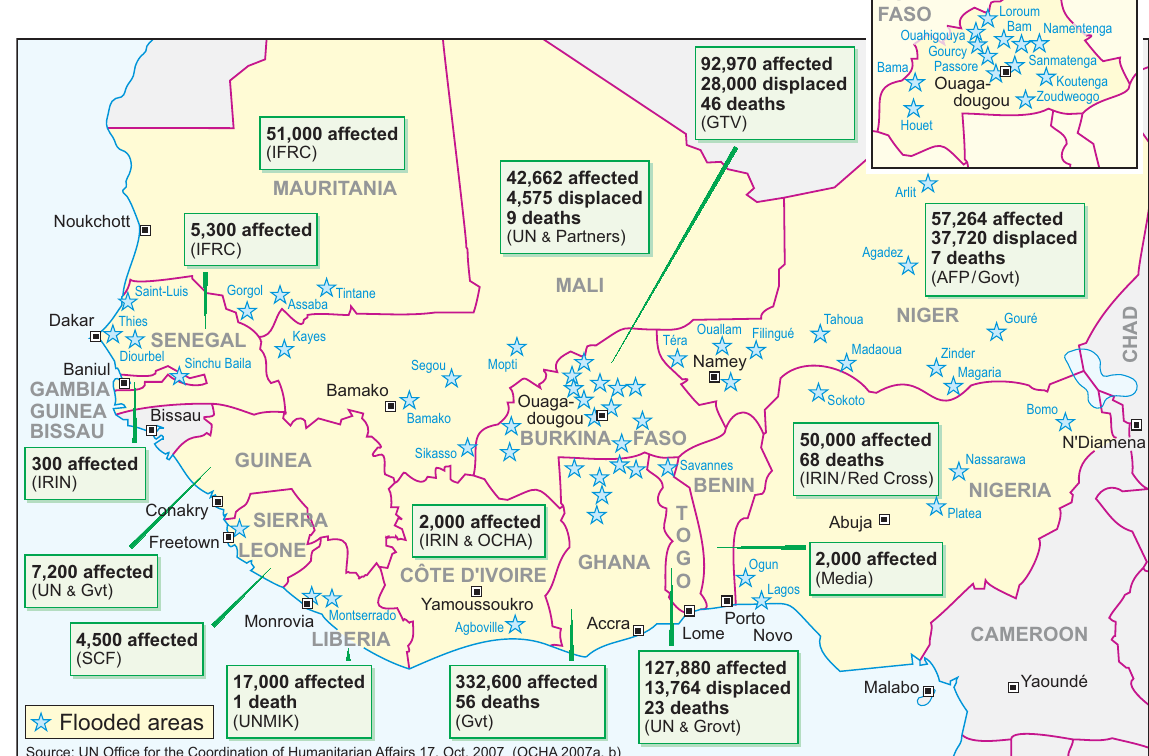
Fig. 7. Countries affected by the 2007 flood in West Africa (based on OCHA, 2007a,